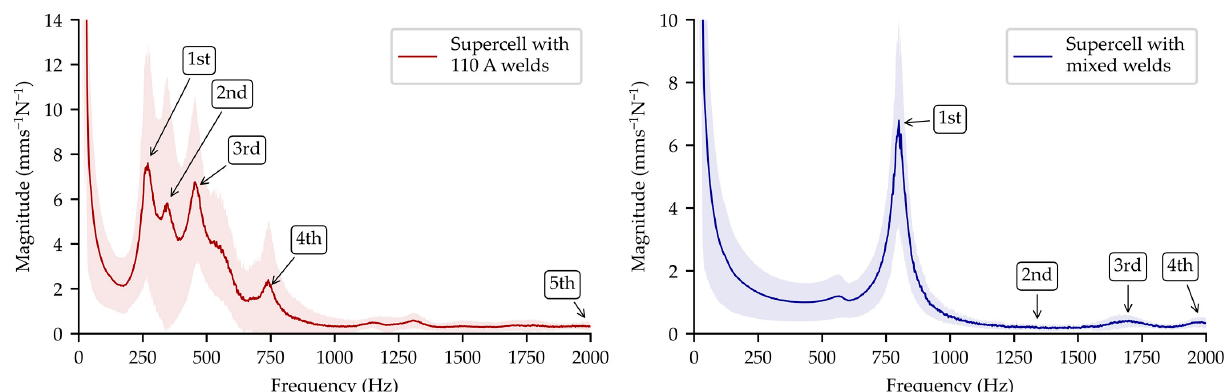
Figure 14. Mean spectra obtained from the tabs at the negative terminals of the supercells. Each line in bold is the mean of 10 FRFs obtained from the centers of each of the welded tabs. Shaded regions represent one standard deviation from the mean of the magnitude. Annotations mark the resonance frequencies of mode shapes obtained by EMA (of the first, second, third, fourth, and fifth mode shapes).